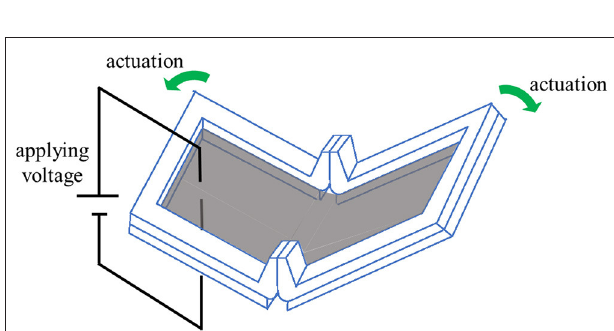
FIGURE 3 | Appearance of self-assembled actuator and mechanism of actuation. The gray area represents an area which the electrode is attached. The electrode is attached to both sides of the elastomer. When a voltage is applied to the electrodes, the actuator is driven in the opening direction.